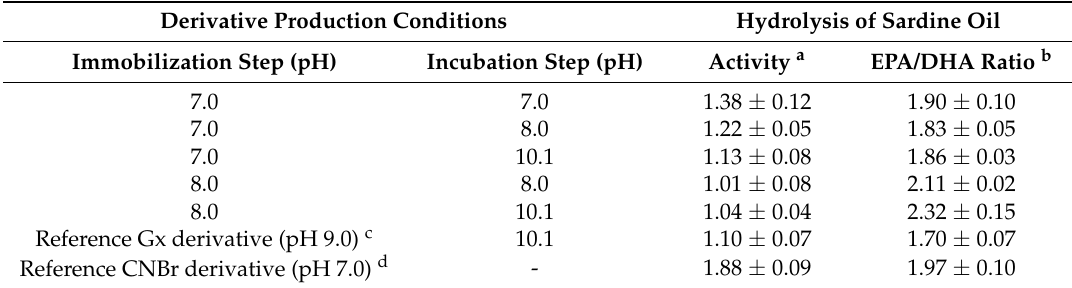
Table 4. BTL2 immobilization on Gx and derivative